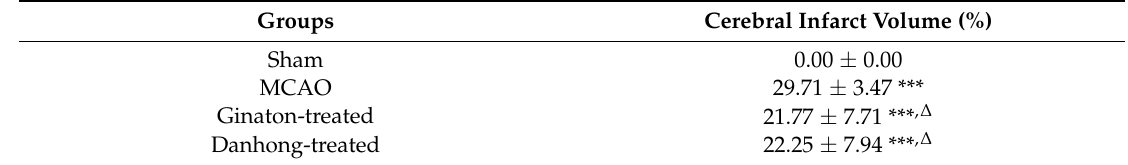
Table 2. TTC staining of the brain for the whole